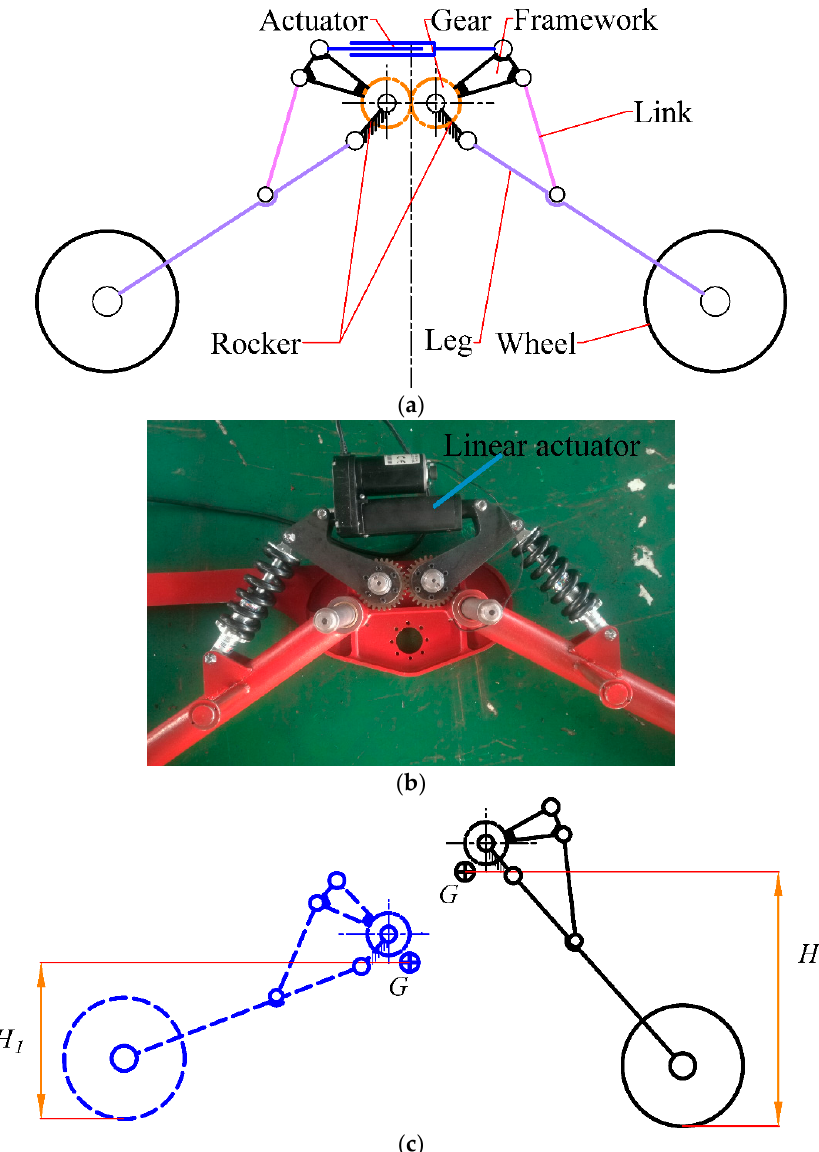
Figure 1. Active suspension: ( a ) Simple model; ( b ) Practical model; ( c ) Principle schematic.